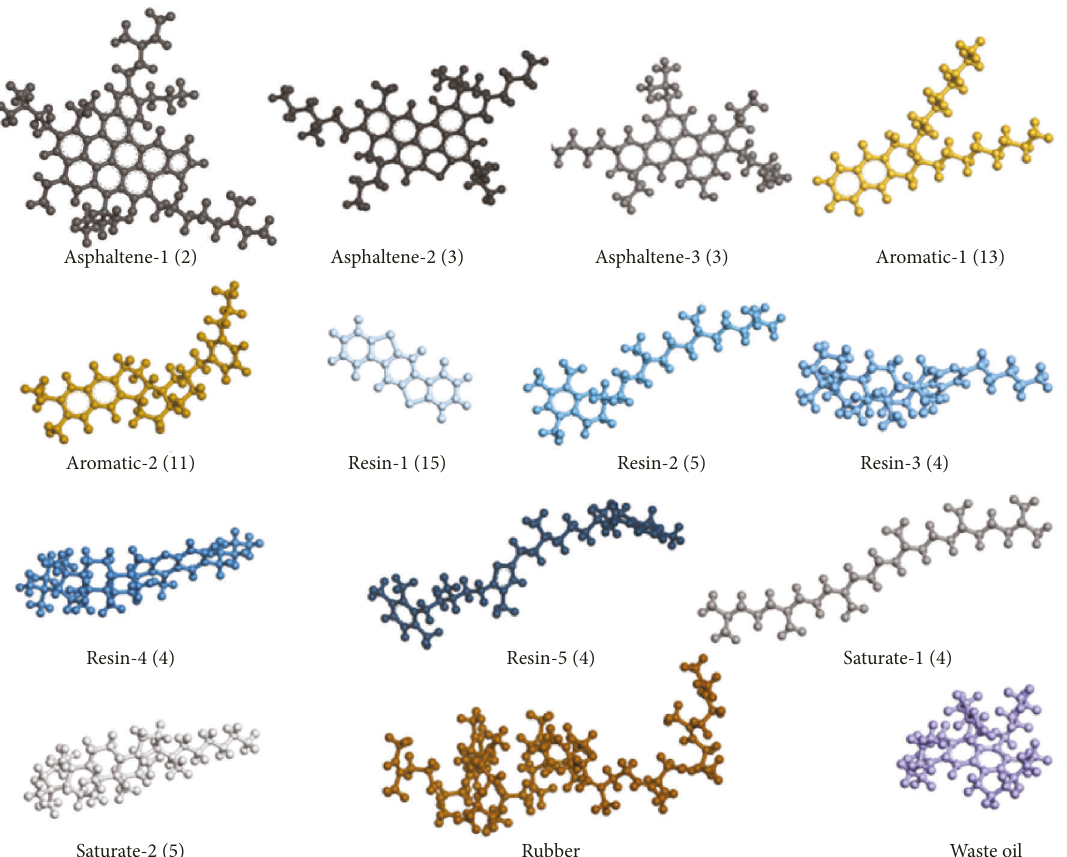
Figure 4: Molecular models of